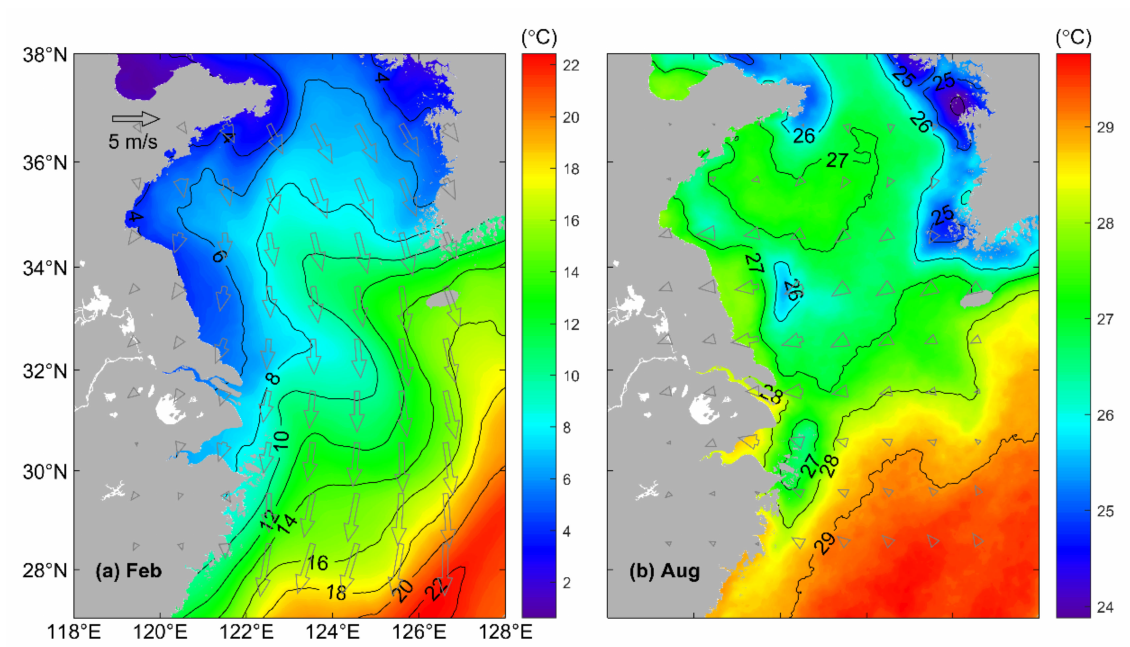
Figure 2. Monthly mean sea surface temperatures (image) and wind velocity vectors (open ar- rows) at 10 m above the mean sea level in ( a ) February and ( b ) August averaged over the 3-year period 2014–2016, based on the satellite remote sensing SST data (MURSST) and hourly atmospheric reanalysis produced by the NCEP,